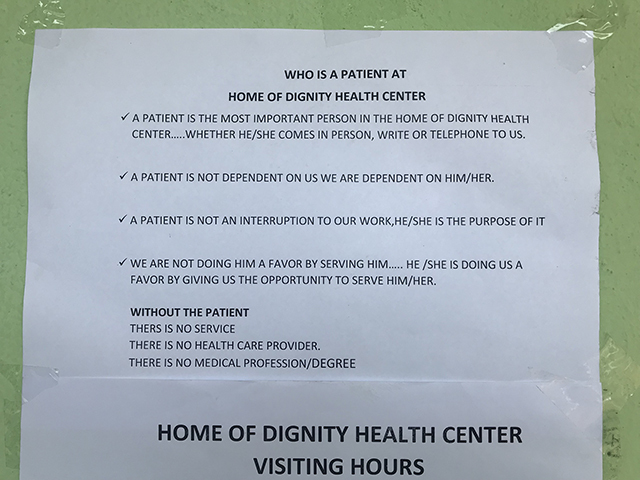
Home of Dignity Mission statement.